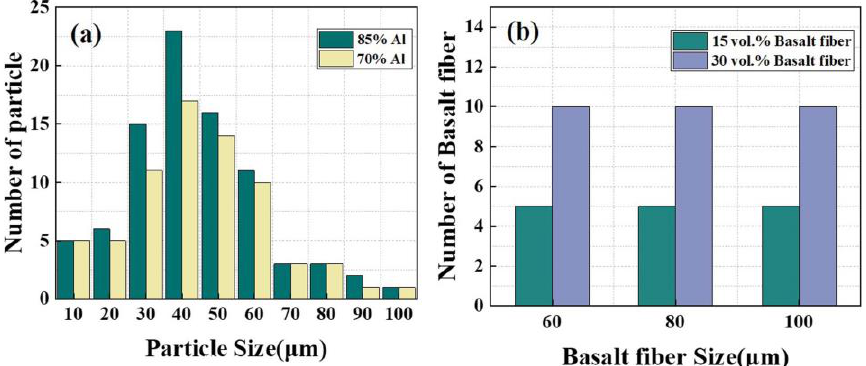
Figure 9. Al – basalt fiber multi-particle random deposition simulation. ( a ) Particle size distribution Al powder. ( b ) Number and length distribution of basalt of Al powder. ( b ) Number and length distribution of basalt fiber.